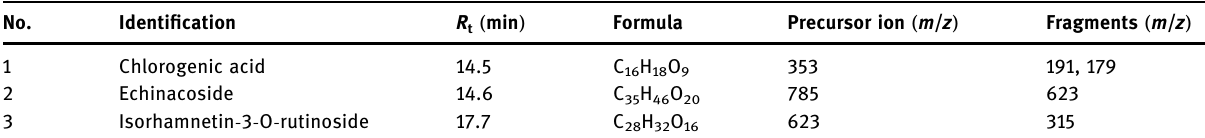
Table 1: The identi fi cations of screened compounds by LC - MS No.